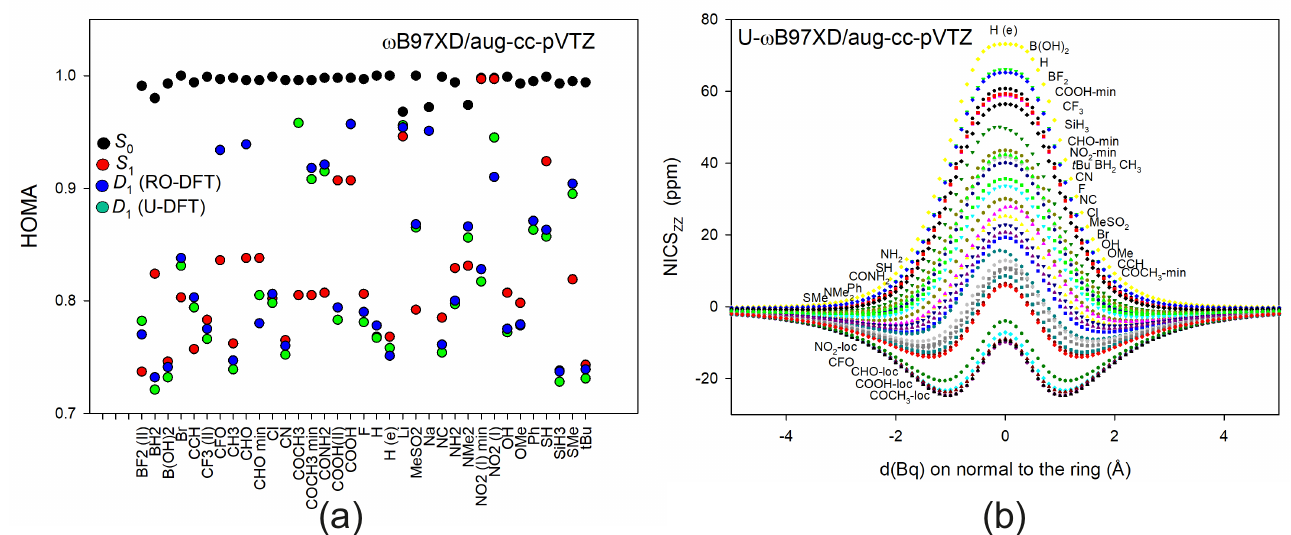
Figure 2. ( a ) A variation of the HOMA aromaticity indices of the monosubstituted benzenes in the S0 ground (black), S1 first excited singlet (red) [74], and the cation radical D1 doublet states (blue and green) calculated using the aug-cc-pVTZ basis set and the ω B97XD, TD- ω B97XD, and U- and RO- ω B97XD method, respectively. ( b ) The NICSZZ scans in monosubstituted benzene cation radicals plotted against sample point distance d(Bq) from the normal to the benzene ring passing through the ring center, which is placed in the origin. The molecule is located in the XY plane. The calculations were performed at the U- ω B97XD/aug-cc-pVTZ